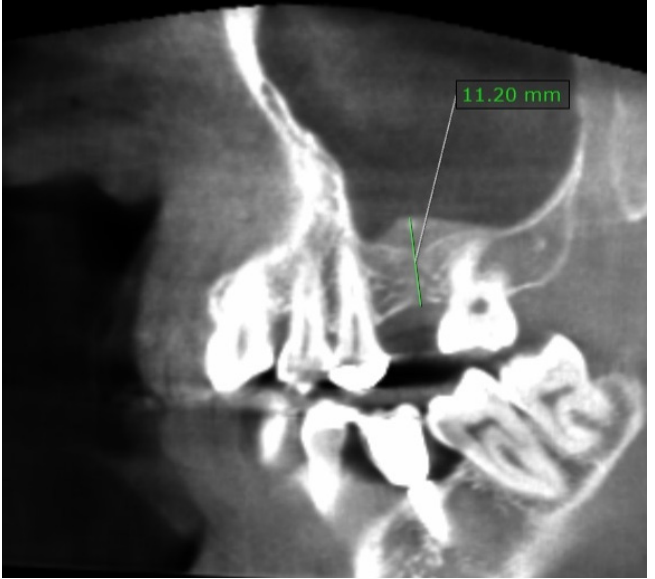
Figure 2. The section of the CBCT showing a residual height of 11.2 mm after 6 months from the sinus lift, meaning an earning bone height of 7.6 mm. The bone seems to be of good quality for dental implant placement.